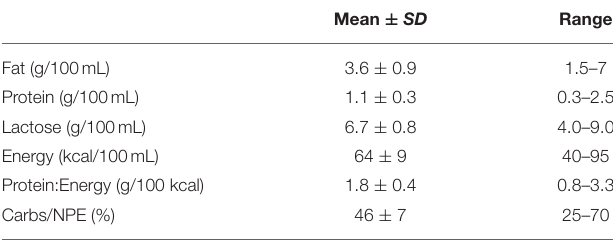
the amount of water to be removed to meet ESPGHAN recommendations at a h feeding volume of 150 mL/kg/d (20).